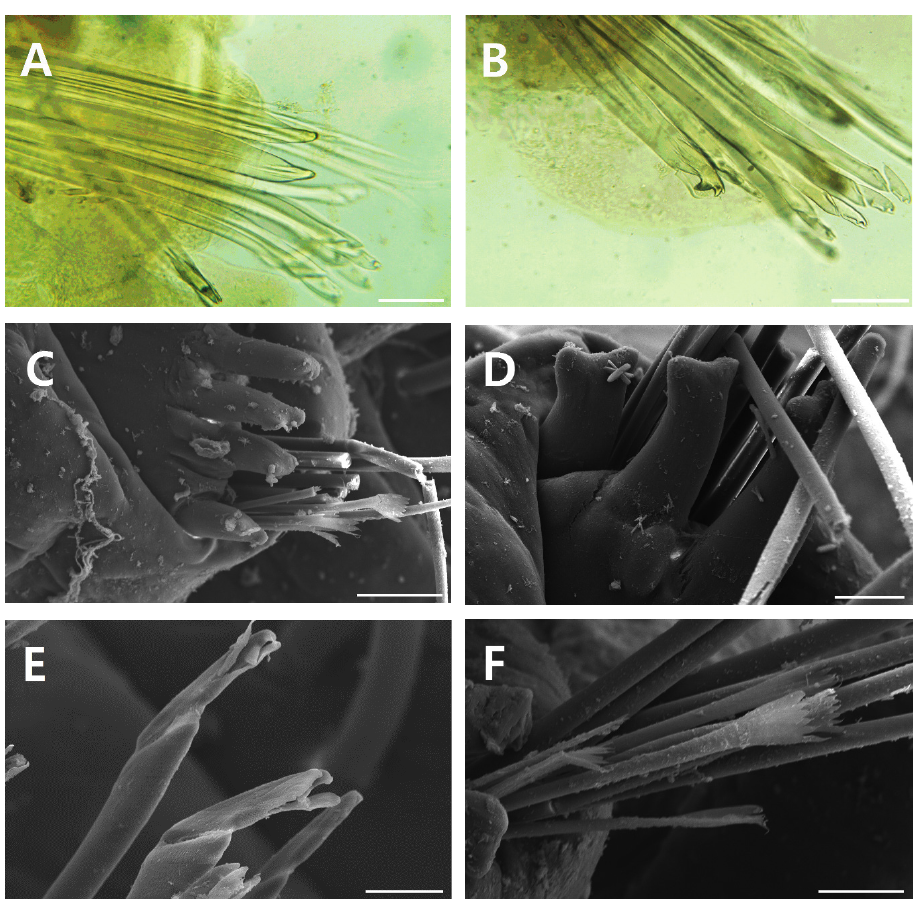
Figure 2. Leodice duplexa sp. n., A–D paratype (MABIKNA00146047) A yellow aciculae with pointed tips B yellow and paired subacicular hooks C parapodium with four aciculae D aciculae with hammer- headed or bifid tips E compound falcigers with bidentate appendages F pectinate chaeta. Scale bars: 0.05 mm ( A–C ), 0.025 mm ( D–F